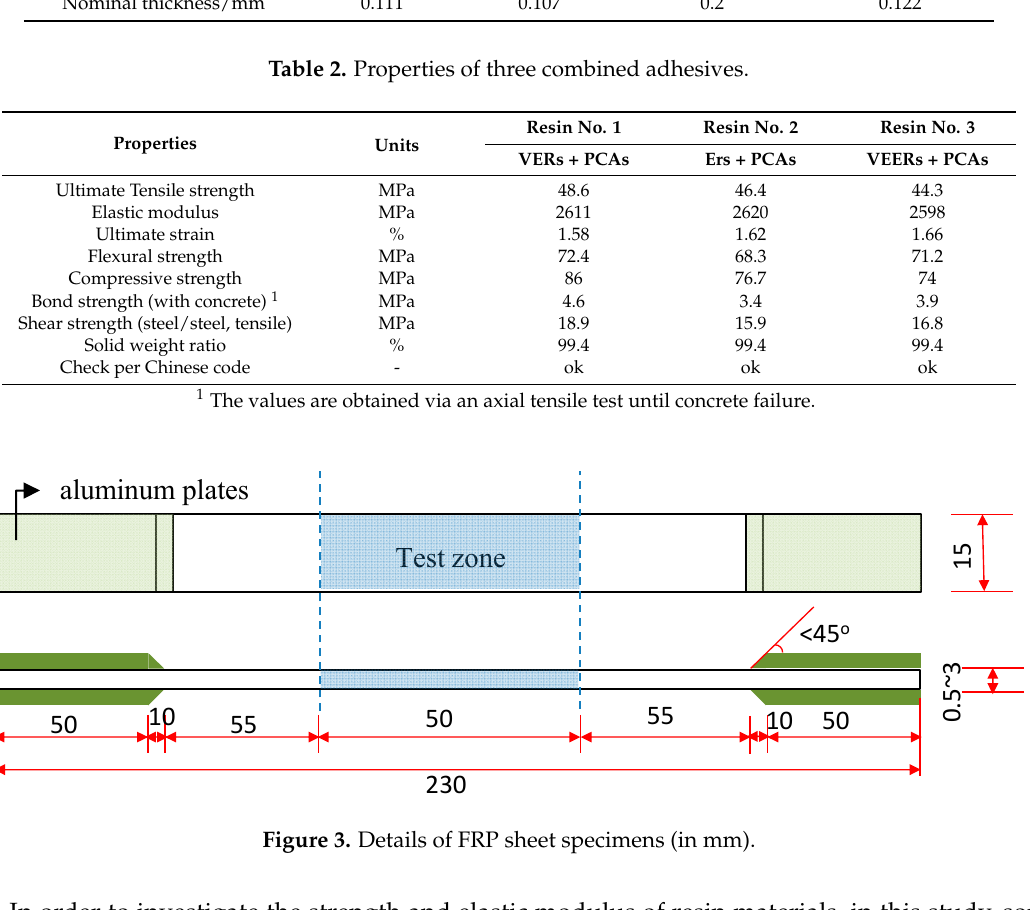
Table 1. Mechanical properties of used f ibre reinforced polymer ( FRP) sheets (provided by the manufacturer).